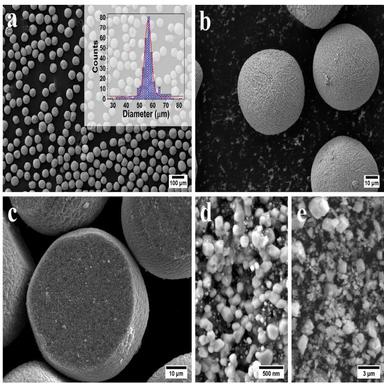
SEM images of ZrC prepared by IG showing (a) microspheres with (inset) diameter histogram fitted by a Gaussian function (red line) and (b) magnified view of microspheres. (c) SEM image of polished microsphere and (d) magnified view of internal ZrC grain structure contrasted with that of (e) ZrC prepared by PVD. Note the scale bar is different between (d) and (e).